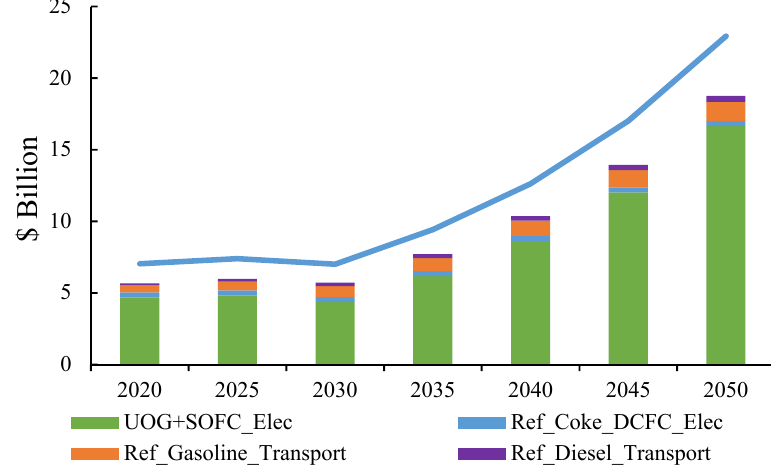
Figure 8. Investment requirements for scenario 1.